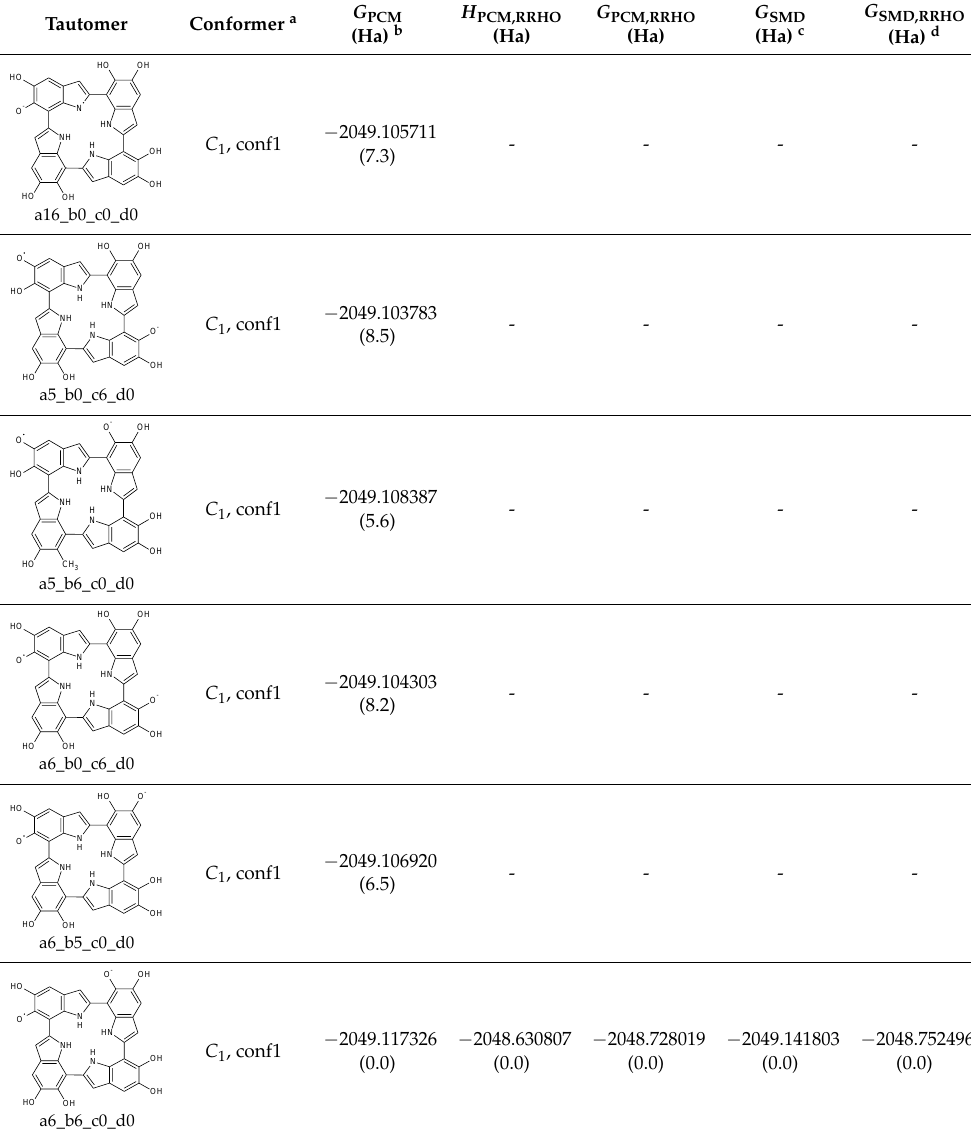
Table 6. KP-1e, monoanionic form in water.